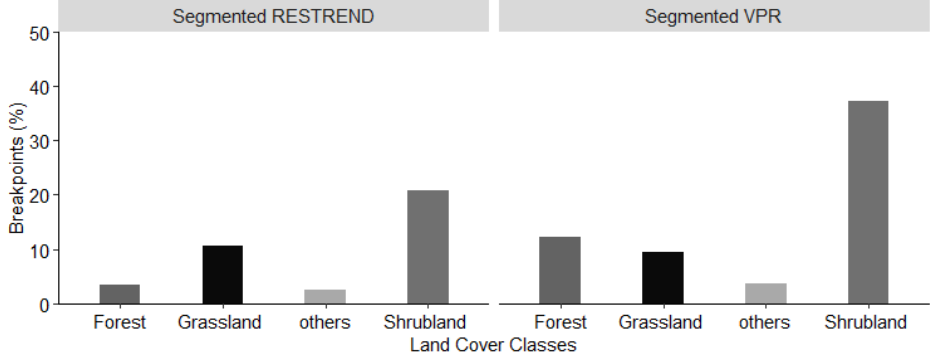
Figure 5. The percentages of breakpoints that were identified within shrubland, grassland, evergreen forest, and other land cover types between 1982 and 2015 in NM categorized by the Segmented RESTREND and Segmented VPR methods.